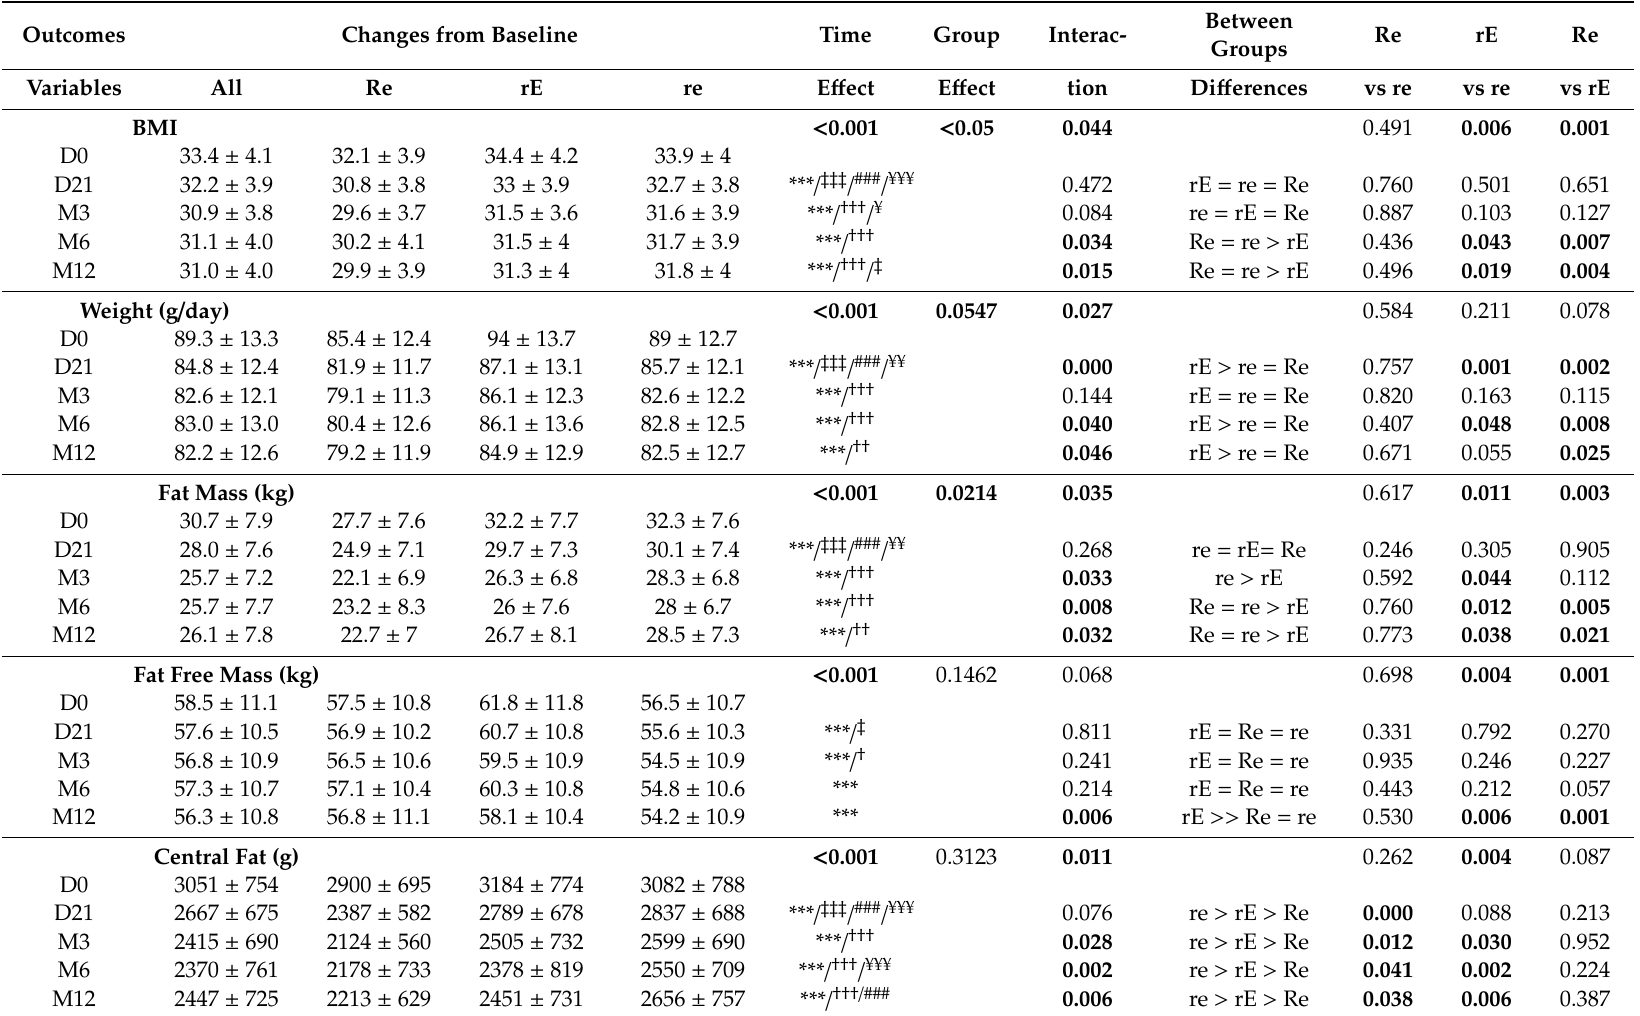
Table 2. Health outcomes